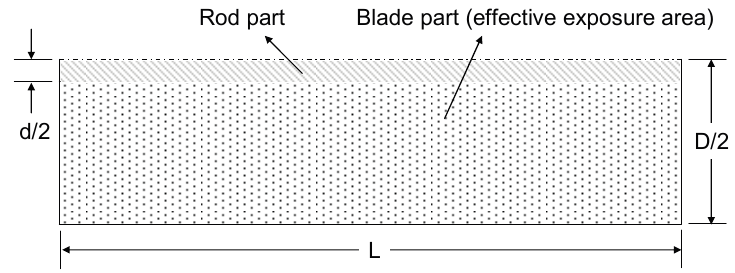
Figure 10. Diagram of effective exposure